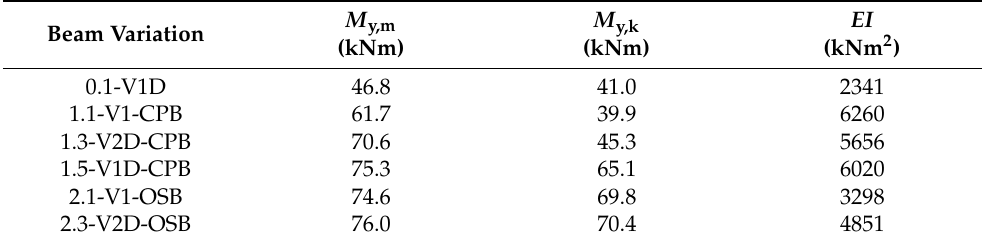
Table 4. Mean and characteristic bending resistance and elastic bending stiffness for the tested beam